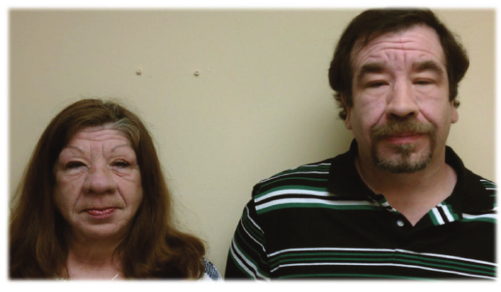
Figure 3: Patient and her son (37 years